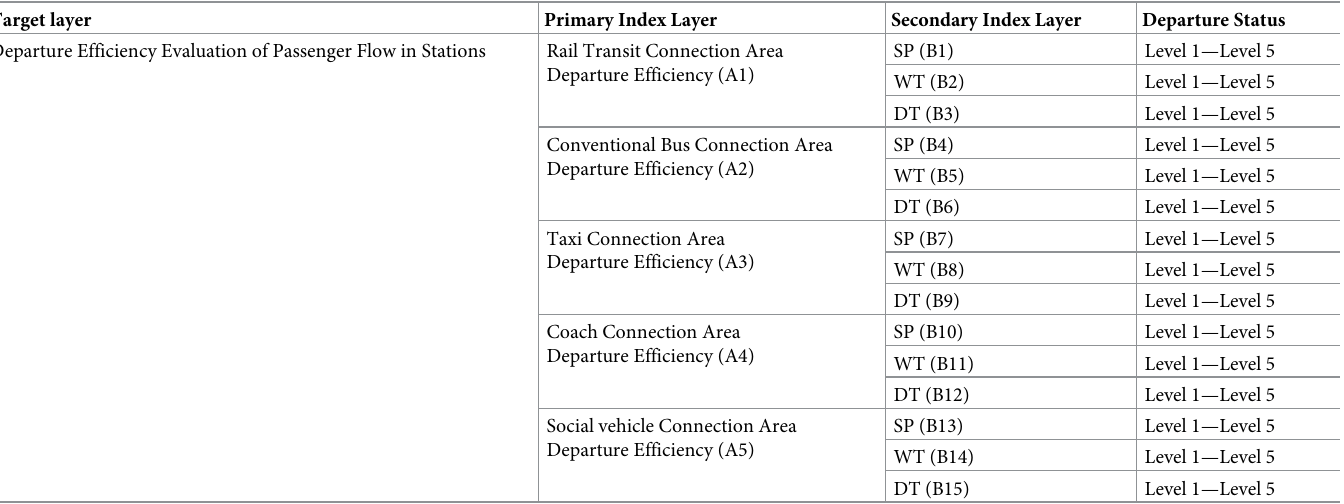
Table 5. Passenger departure efficiency evaluation index system.